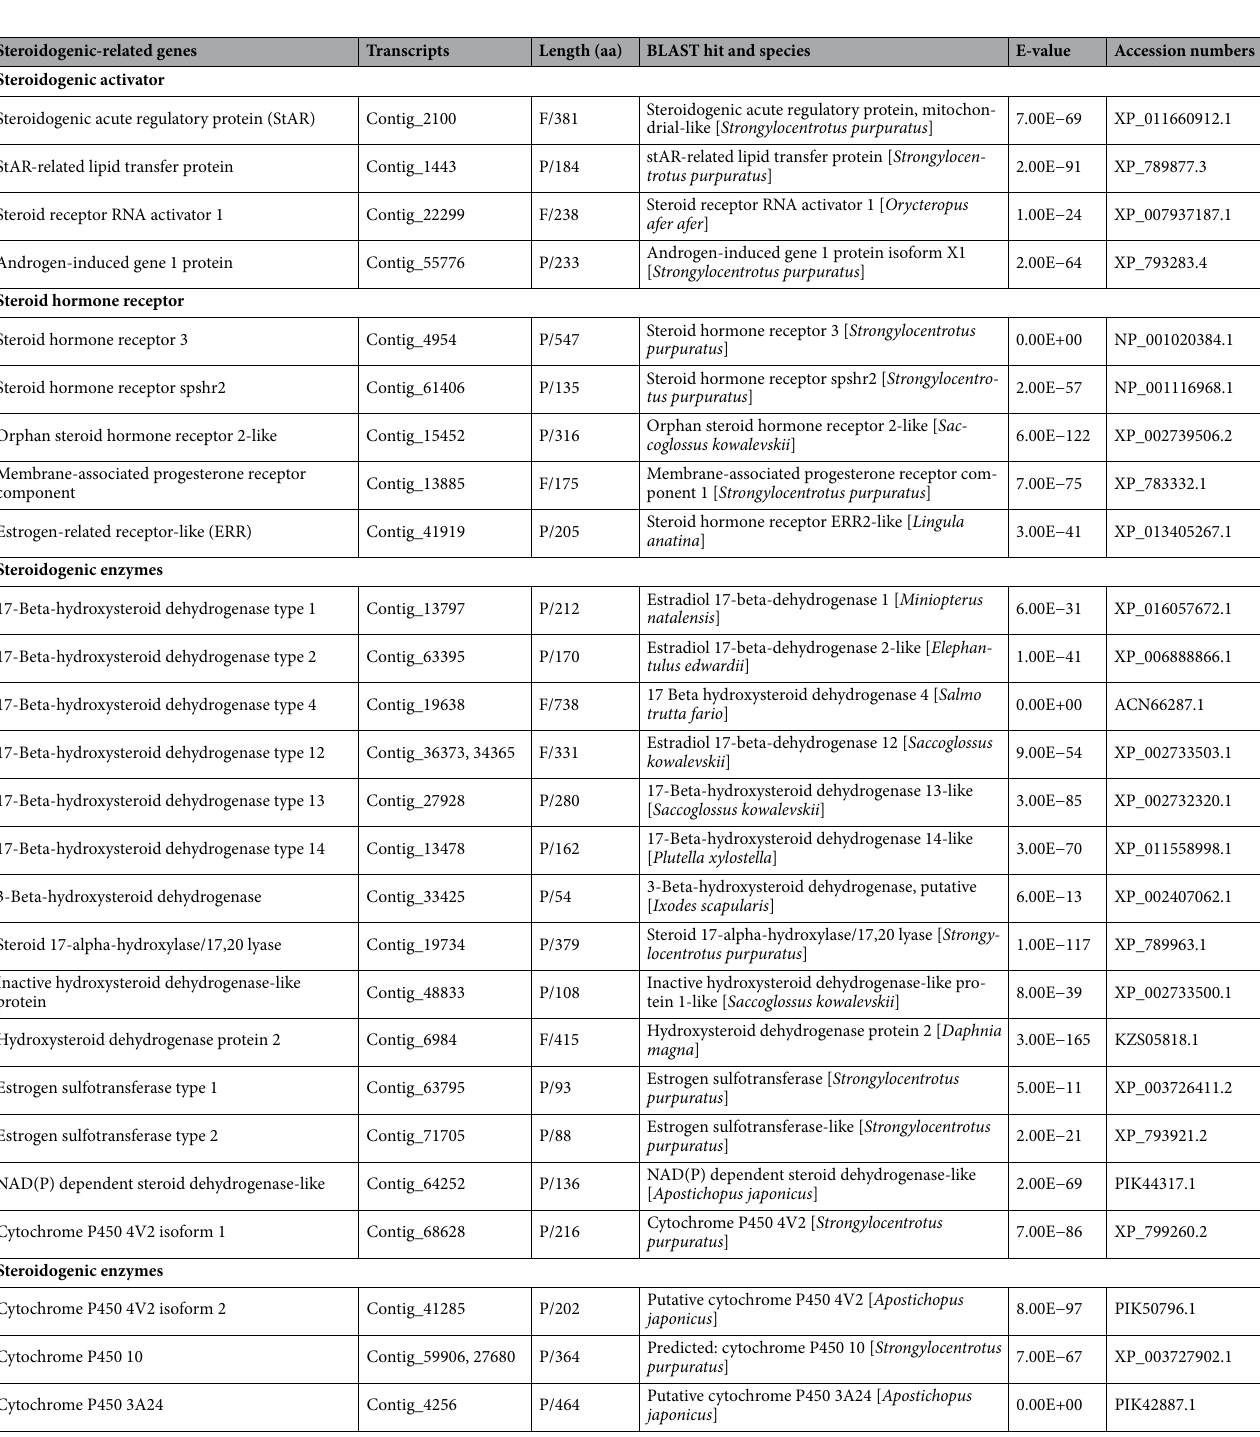
Table 2. Summary, including BLAST annotation, of genes found in H. scabra involved in the steroidogenesis pathway. P; Partial sequence, F; Full-length sequence. Amino acid sequences are shown in